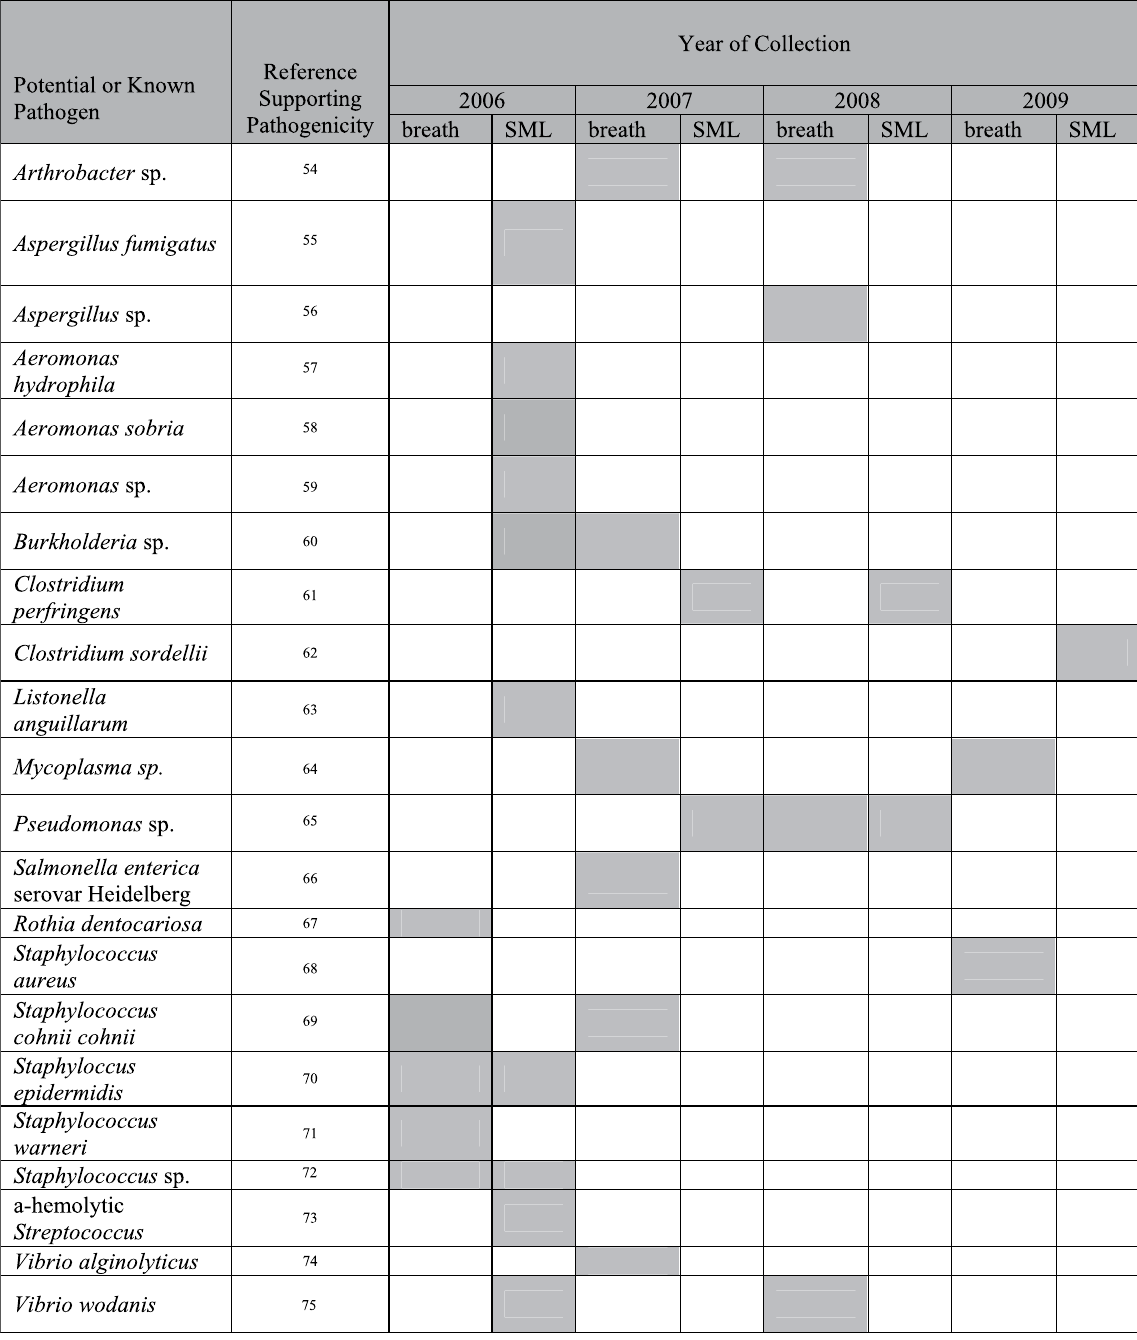
Table 2. Potential and known human or animal pathogens identified in SRKW exhaled breath and SML samples 54–75 . Gray-filled cells in the matrix indicate detected microbe in the